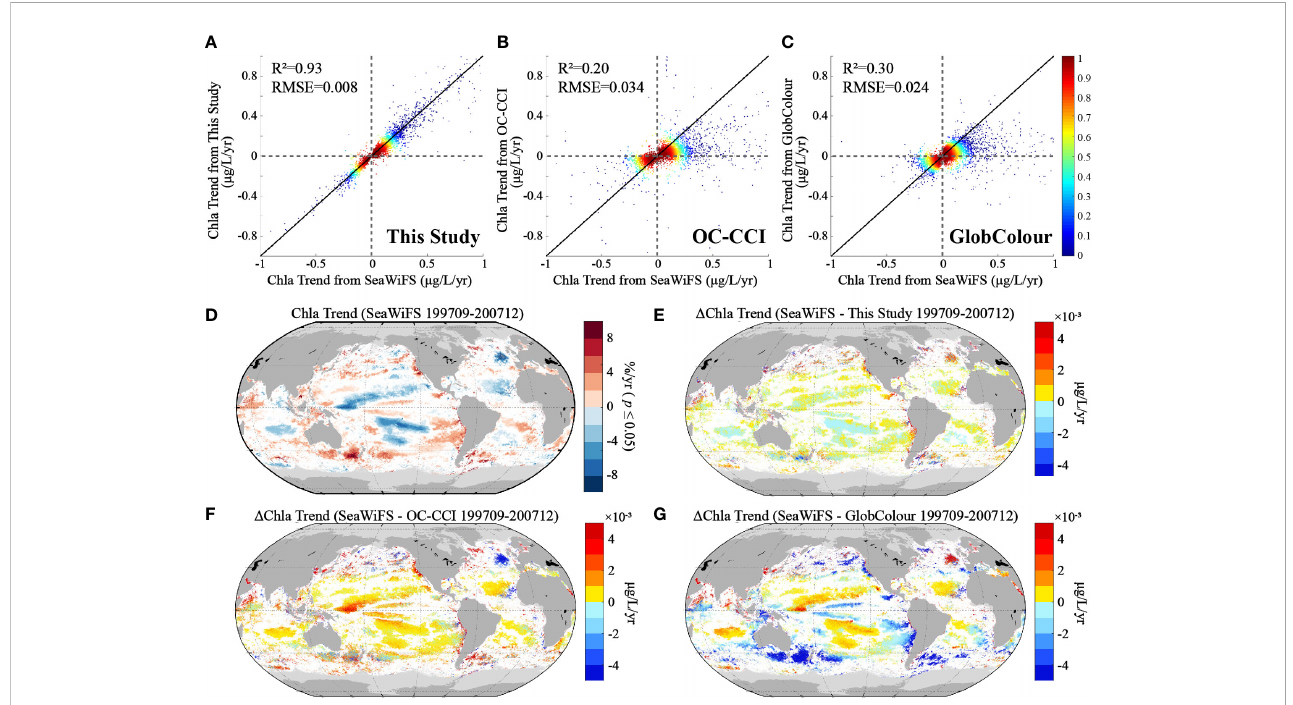
FIGURE 5 (A – C) Scatter plots of pixel-by-pixel Chla trends comparison between SeaWiFS and the three merged datasets from September 1997 to December 2007. (D) Chla trend maps in units of %/yr from SeaWiFS for September 1997 to December 2007. (E – G) Chla trends from SeaWiFS minus that from the three merged datasets in units of m g/L/yr. Black lines on the scatter plots represent the 1:1 line, and the color scale indicates the data density in pixels. The light gray on the maps represents insuf fi cient data for making a trend calculation (i.e., the number of valid data collected in the statistical period (62 months) does not reach 50%), and the white color indicates that the SeaWiFS data show that the pixel has not changed signi fi cantly ( p < 0.05).